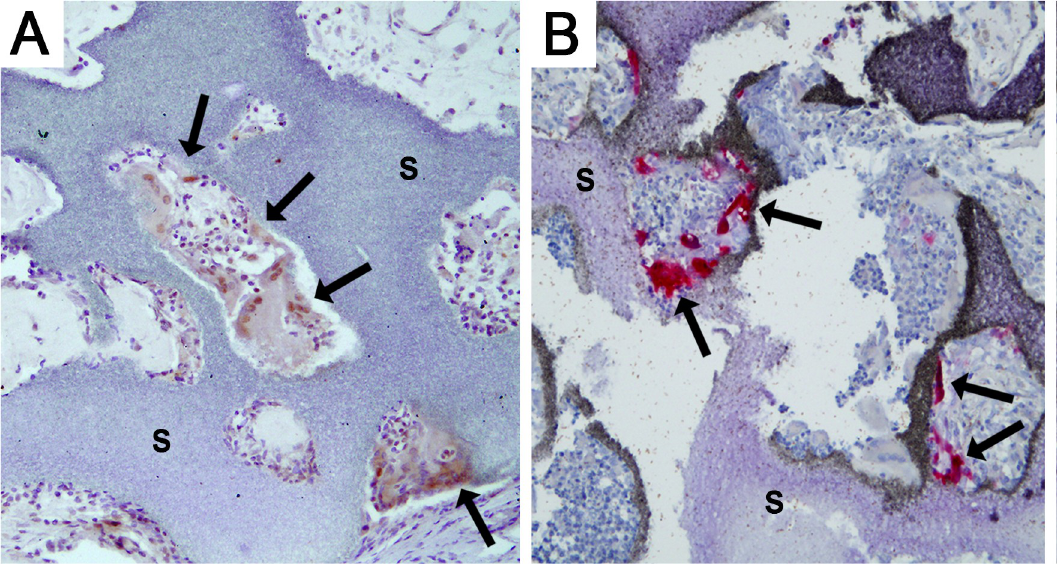
Fig 5. Characterization of the cells expressing BMP-2. BMP-2 immunohistochemistry (A) and TRAP staining for cells of the macrophage lineage (B) were performed on sections of the same group (pBMP-2 + MSCs). Cells aligning the scaffold, indicated with the arrows, are stained BMP-2 positive (brown in A) and TRAP positive (red in B). s = scaffold. Scale bar = 200 μ m.